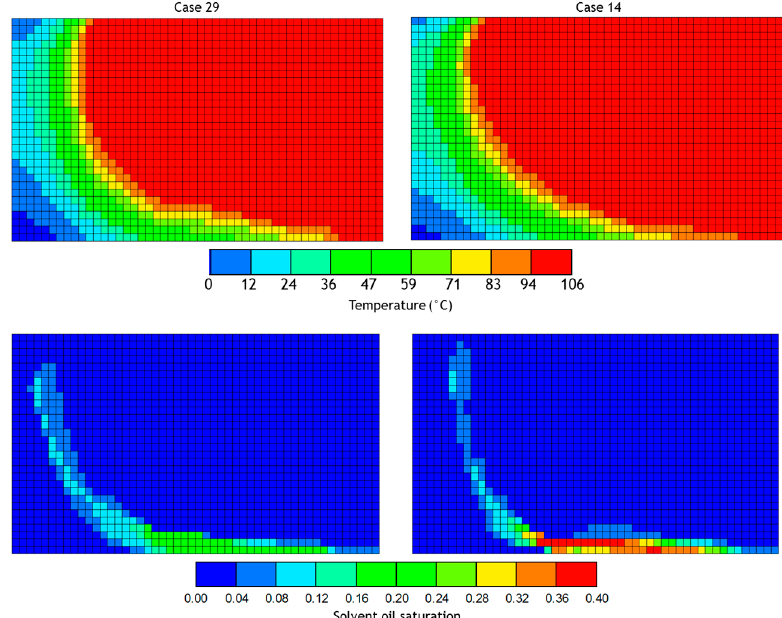
Figure 14. Temperature and solvent saturation in oil phase for two cyclic ES-SAGD cases in which hexane at 10% mole was injected at di ff erent times. Although there is a subtle di ff erence in the steam chamber size for both processes, it can be observed how there is more solvent in the oil phase in Case 14 at the end of the simulation.